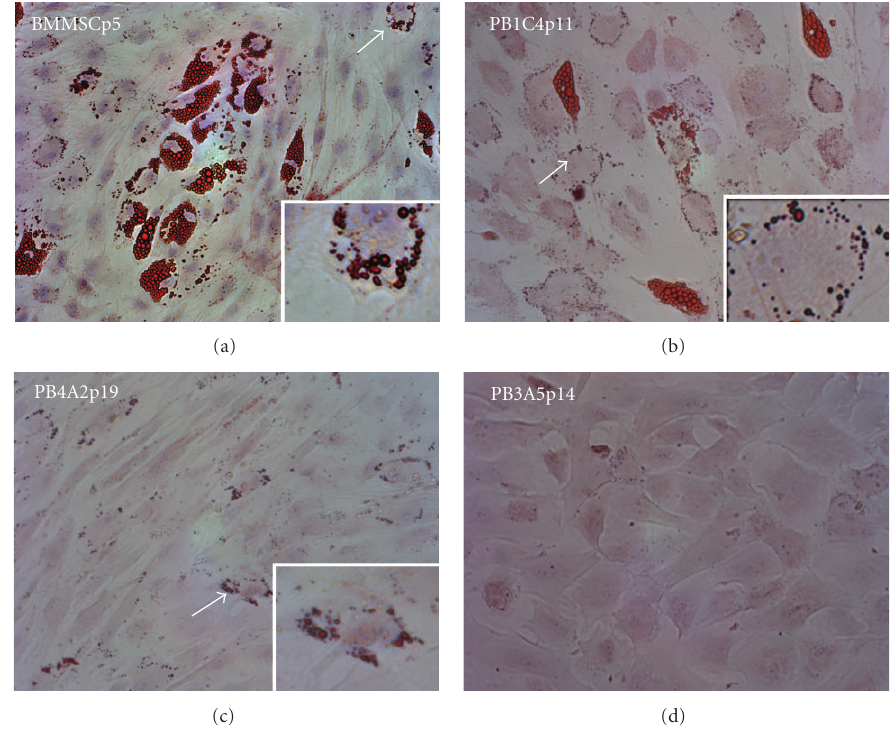
Figure 4: Adipogenic di ff erentiation. Populations of BMMSCp5, PB4A2p19, PB1C4p11, and PB3B5p14 cells were maintained in adipogenic media for 3 to 4 weeks. Representative bright field images show robust adipogenic di ff erentiation in BMMSCs and PB1C4 cell populations as indicated by oil red-O stained spheres. Arrows and inserts indicate very small oil red-O positive spheres in BMMSC, PB4A2, and PB1C4 populations that were not detected in PB3B5 populations. Magnification is identical in all